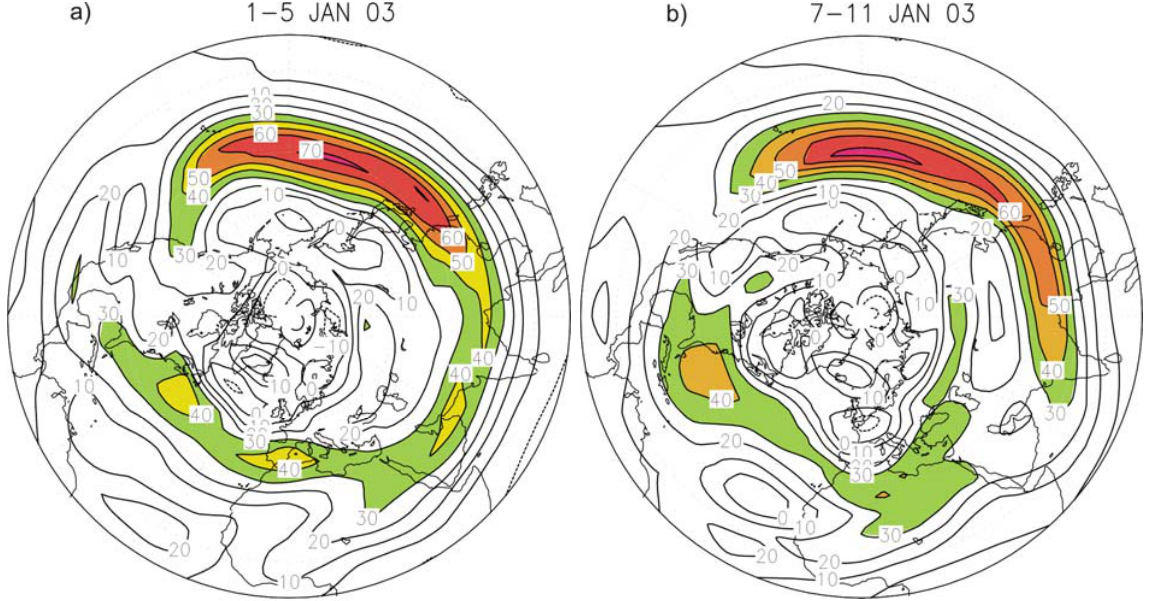
Fig. 9. Stereographic projection of the zonal wind at 300hPa for the period 1–5 (a) and 7–11 January 2003 (b) . Values > 30ms − 1 are Figure 9: Stereographic projection of the zonal wind at 300 hPa for the period 1-5 (a) and 7- colored. 11 January 2003 (b). Values > 30 m s -1 are colored.